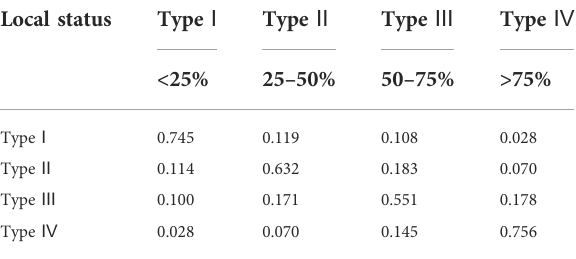
TABLE 3 Traditional Markov chain probability transfer matrix of the eco-ef fi ciency of RED in the study